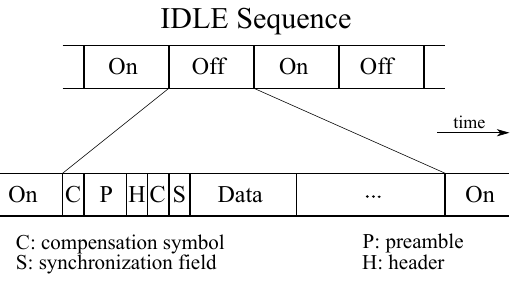
Figure 2. IDLEsequence and data dimming compensation.